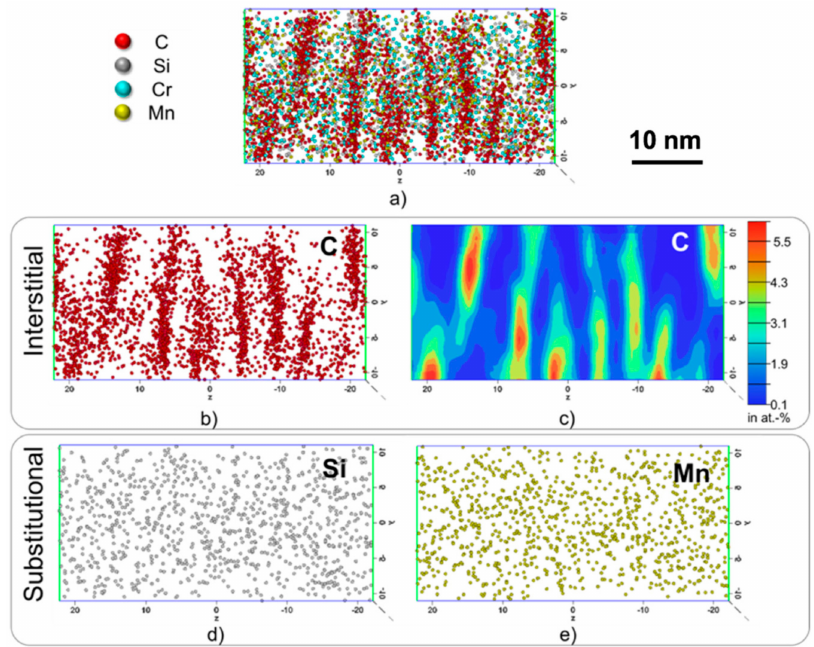
Figure 5. ( a ) Overview of the alloying elements C, Si, Mn and Cr within the ROI in form of a 2D-atomic map; ( b ) C atoms distribution; ( c ) 2D concentration map of C; ( d ) Si atoms distribution; and ( e ) Mn atoms distribution.